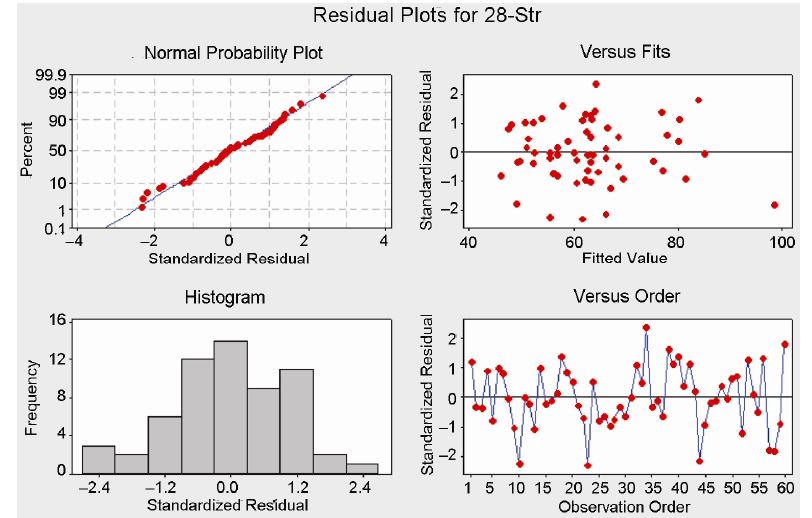
Fig. 1. Residual plots of the 28-day strength model